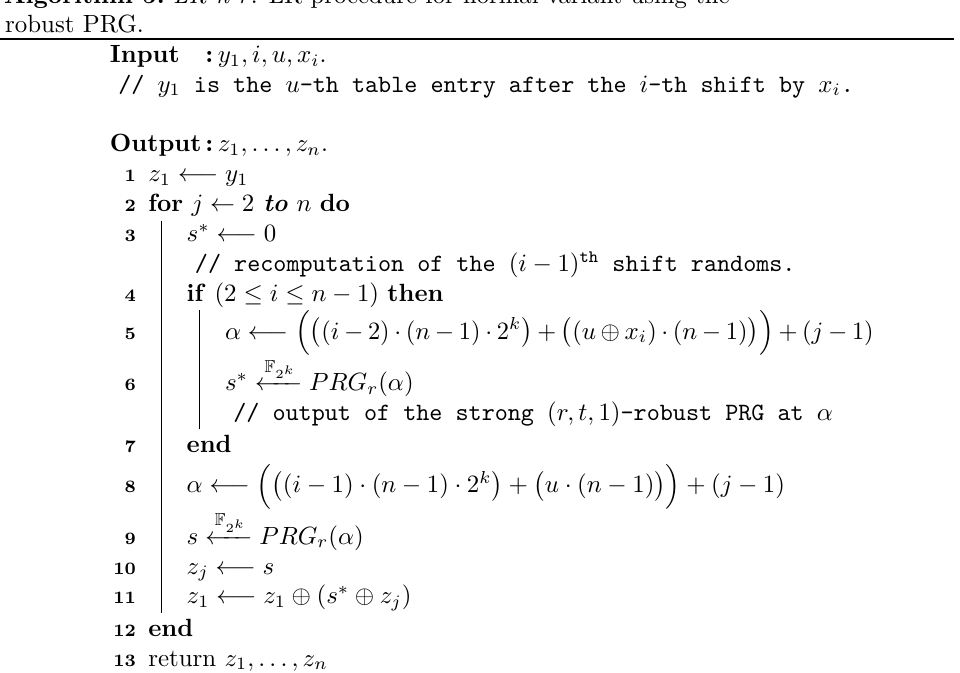
Algorithm 5: LR-n-r : LR procedure for normal variant using the robust